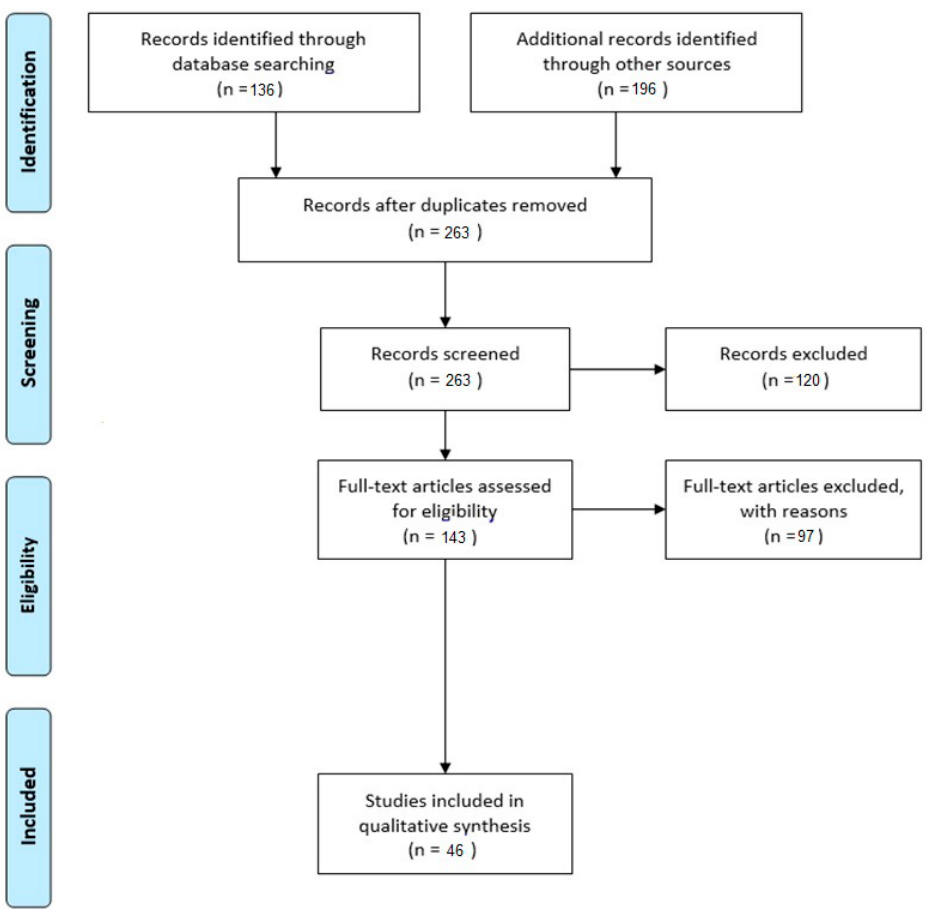
Figure 1. Flow diagram of the review process.